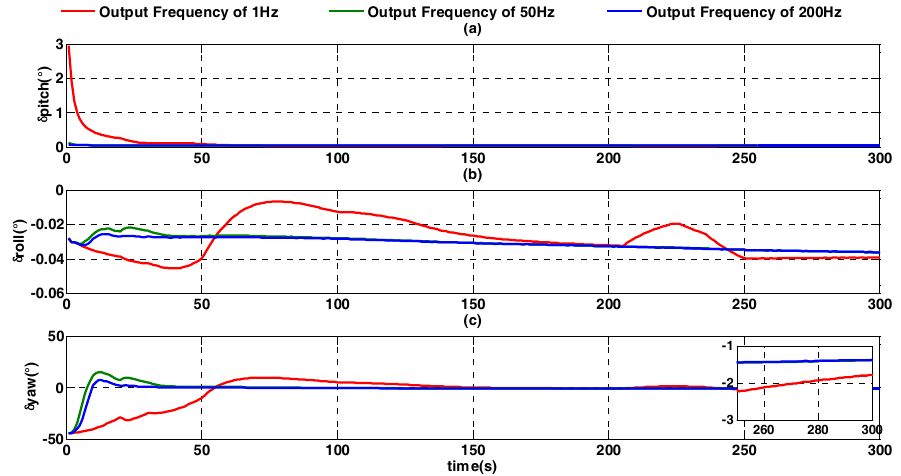
Figure 9. Alignment error curves at different output frequency of velocity. ( a ) The error curves of pitch angle; ( b ) the error curves of roll angle; ( c ) the error curves of heading angle.